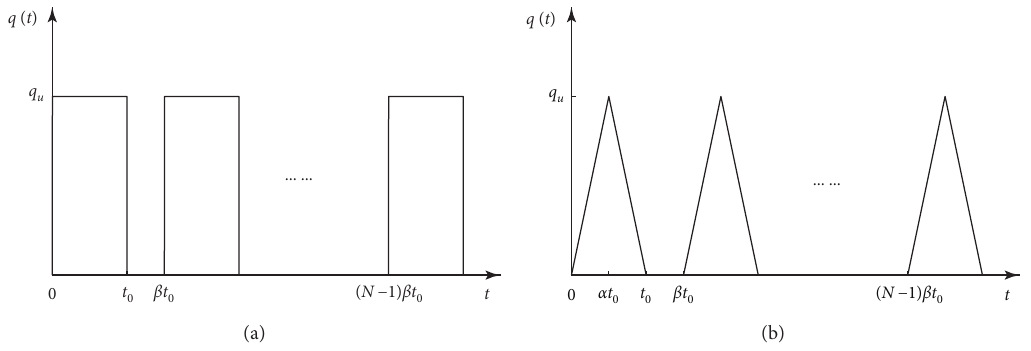
Figure 3: Rectangular cyclic loading (a) and triangular cyclic loading